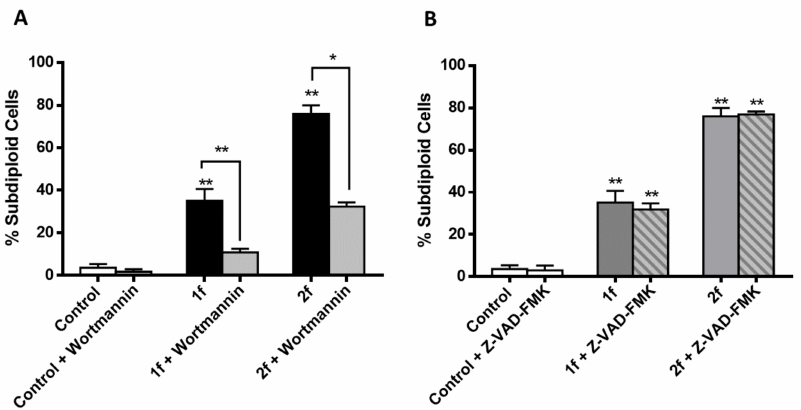
Figure 8. Cell death induced by compounds I.1f and I.2f blocked by wortmannin ( A ) but not by pan-caspase inhibitor Z-VAD-FMK ( B ). * Statistical significance with values of p < 0.05; ** statistical significance with values of p <